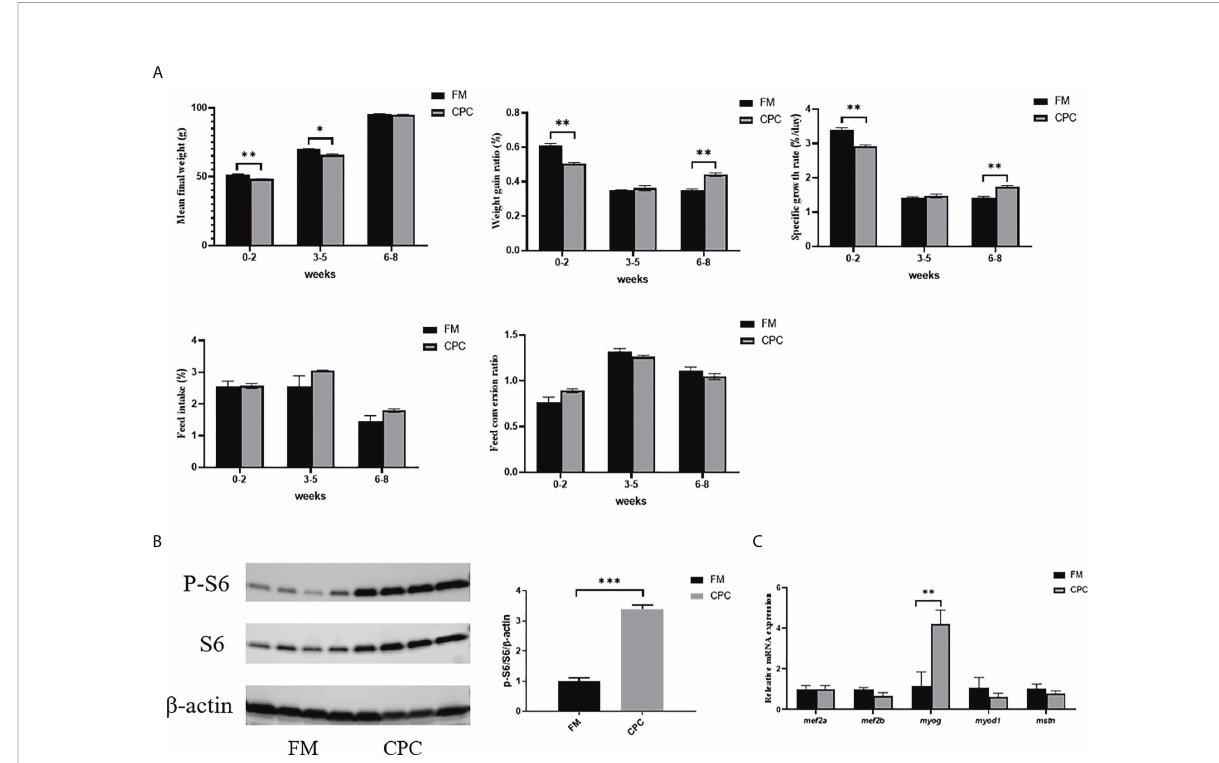
FIGURE 1 Largemouth bass exhibited better growth potential after adaptation to dietary CPC. (A) The growth parameters including mean fi nal weight (MFW, g), weight gain ratio (WGR, %), speci fi c growth ratio (SGR, %/day), feed intake ratio (FI, %/day) and feed conversion ratio (FCR) of juvenile largemouth bass fed with FM and CPC in 0-2 weeks, 3-5weeks and 6-8 weeks. (B) The relative protein level of S6 and P-S6 in liver of juvenile largemouth bass fed with FM and CPC. (C) The relative mRNA expression levels of genes involved in muscle formation ( mef2a, mef2b, myog, myod1, mstn ) in the liver of juvenile largemouth bass in both FM group and CPC group. All data was analyzed with student ’ s t-test and data are means ± SD (n = 6). *P< 0.05; **P< 0.01; ***P<